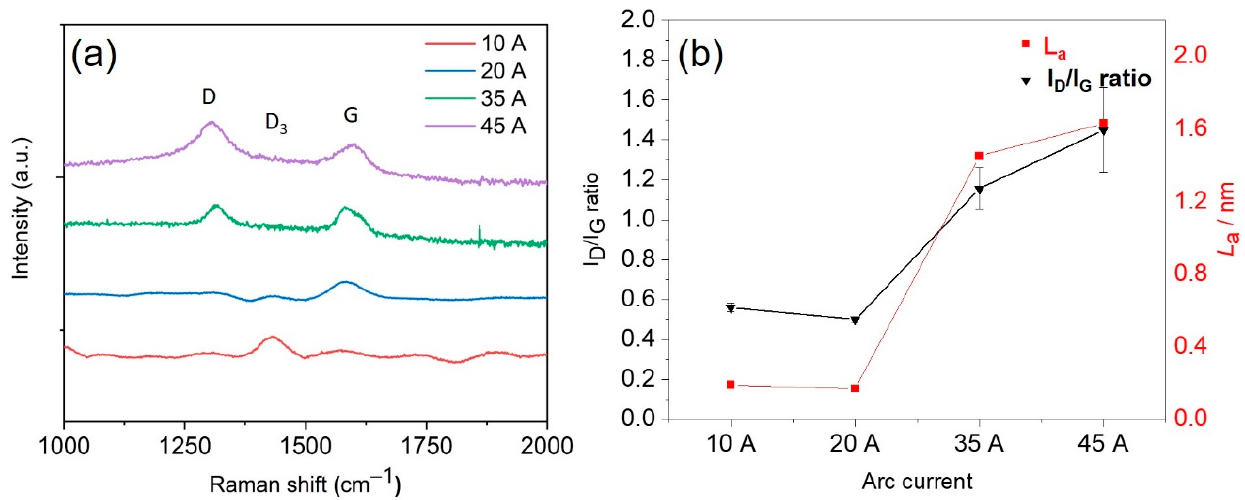
Figure 4. ( a ) Raman spectra of lignin fibres treated with different arc currents. ( b ) Dependence of I D /I G ratio and graphite crystallite size ( L a ) on arc currents.